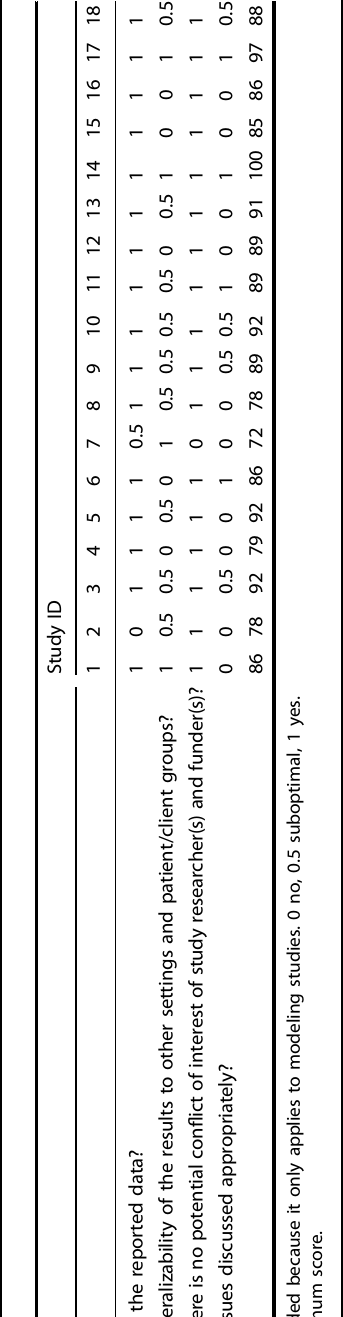
Supplementary Table 1 displays the following characteristics and outcomes for each of the included health economic